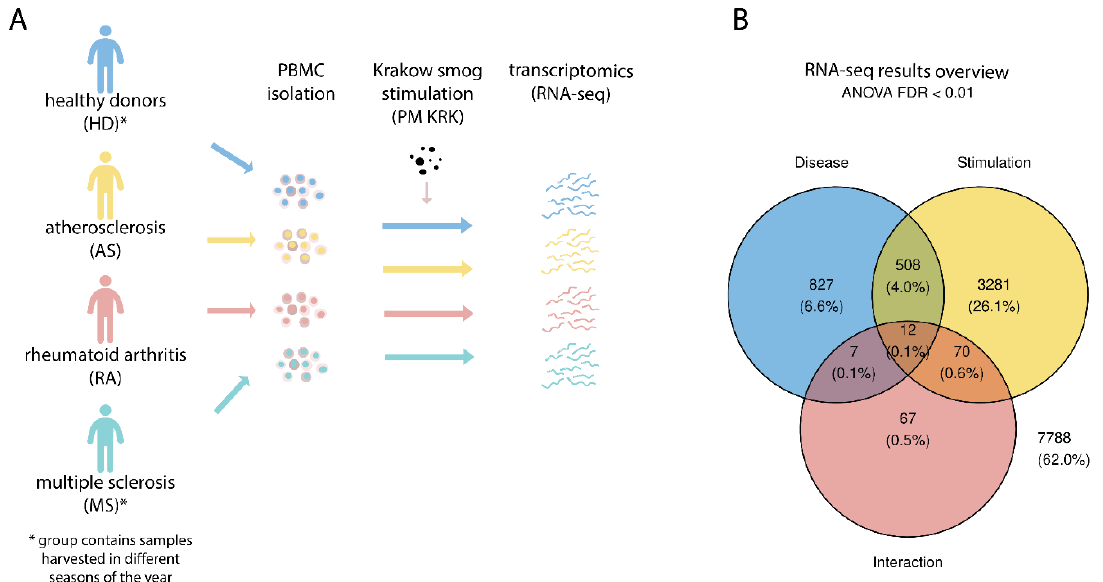
Figure 1. Overview of the study. ( A ) Peripheral blood mononuclear cells (PBMCs) were isolated from healthy donors (HD) and patients with rheumatoid arthritis (RA), multiple sclerosis (MS), and atherosclerosis (AS). Cells were then stimulated with smog particles (PM KRK) and their transcriptome analyzed and compared to non-stimulated cells. ( B ) Transcript counts were transformed, normalized, and analyzed with two- way ANOVA. The Venn’s diagram shows each factor’ s number of differentially expressed genes.